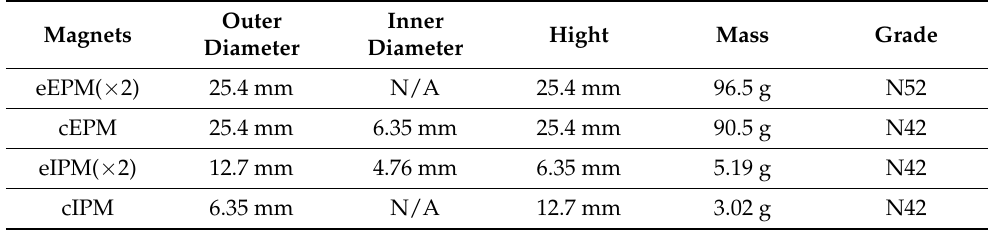
Table 1. Physical attributes of magnets 1